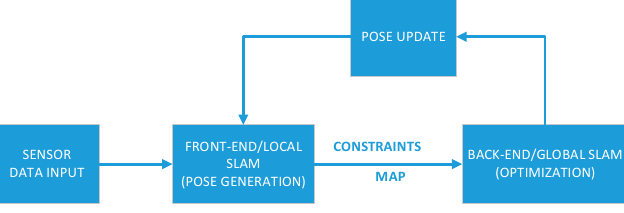
Figure 1. Simultaneous localization and mapping (SLAM) framework.